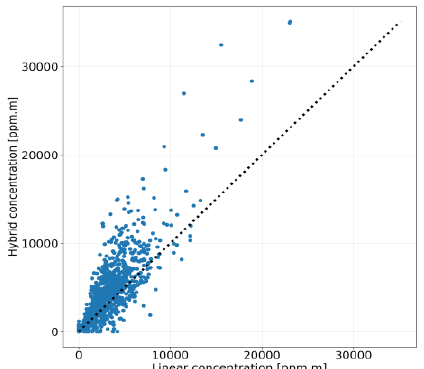
Figure 13 . Hybrid retrieved concentration according to the linear retrieved concentration, in ppm.m.